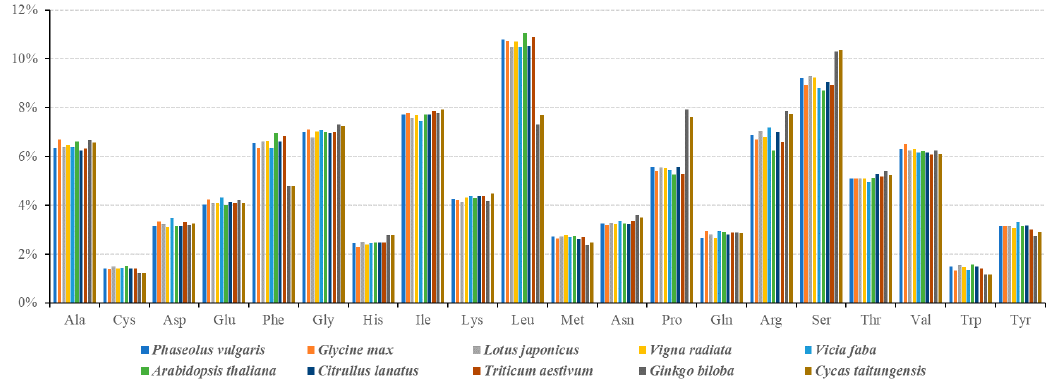
Figure 3. Codon usage pattern of P. vulgaris mitogenome compared with nine other higher plants. The proportion of each amino acid residues to the whole mitochondrial proteins is shown on the Y-axis. Ginkgo biloba and Cycas taitungensis are gymnosperms, while others are angiosperms.